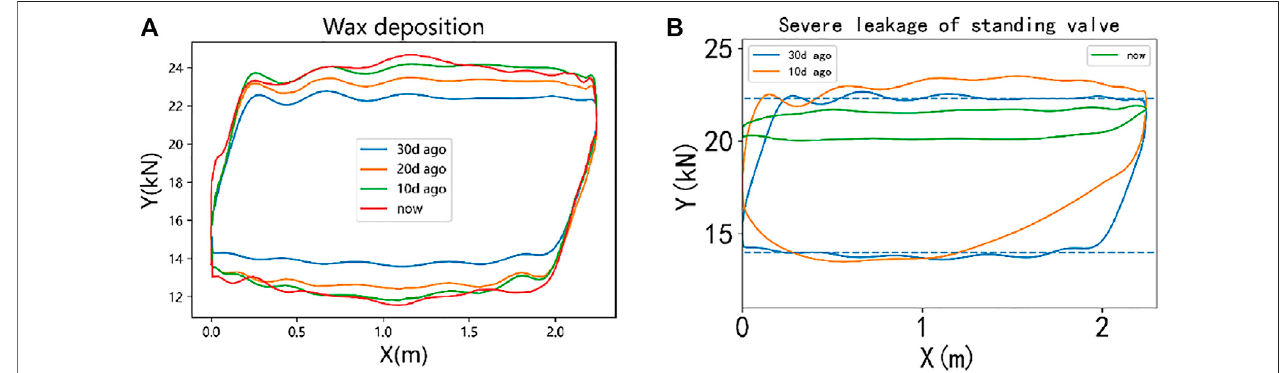
FIGURE 5 | The change trend of dynamometer card of two different working